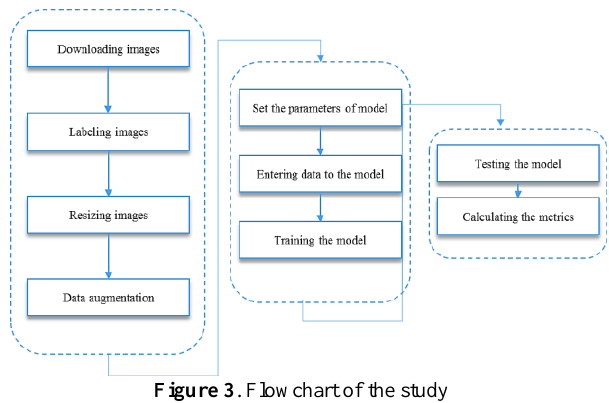
Figure 3 . Flowchart of the study